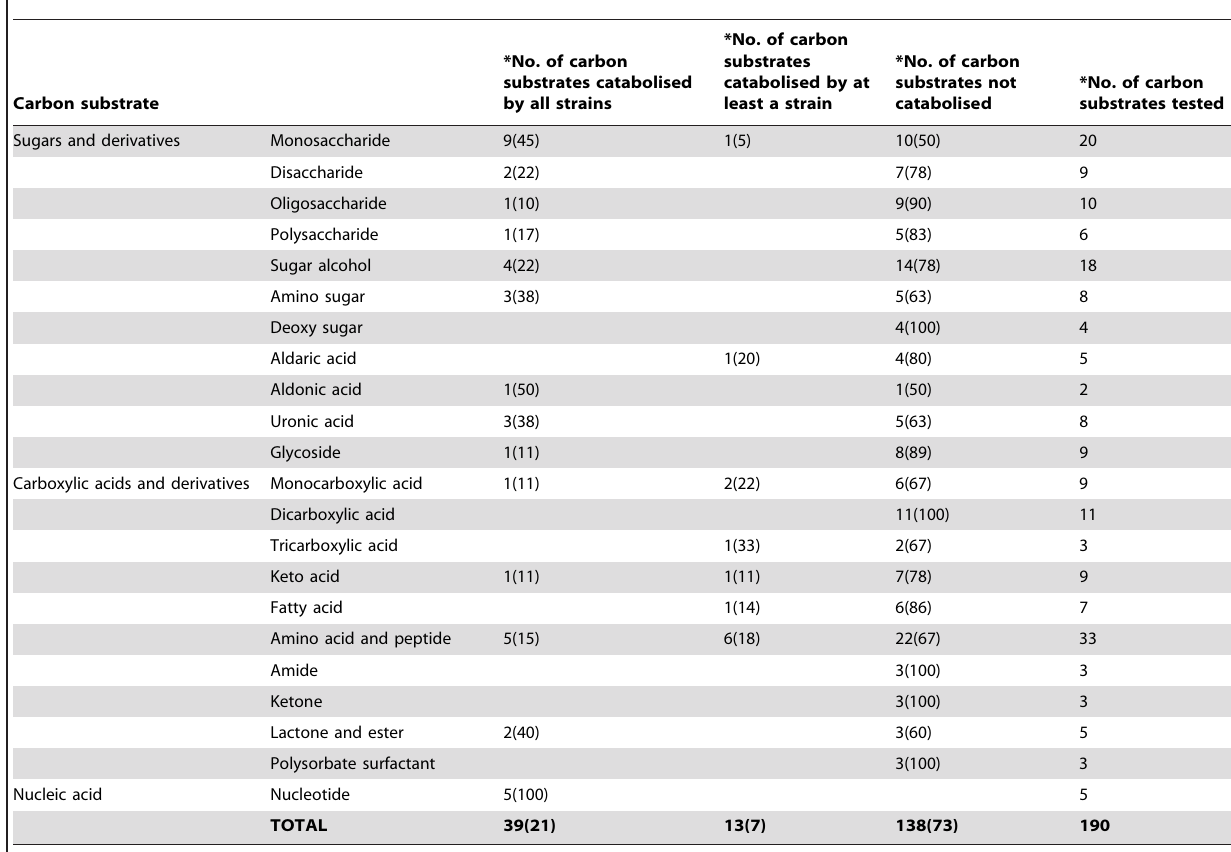
Table 2. Catabolism of 190 carbon substrates by Salmonella enterica serovar Typhi strains.